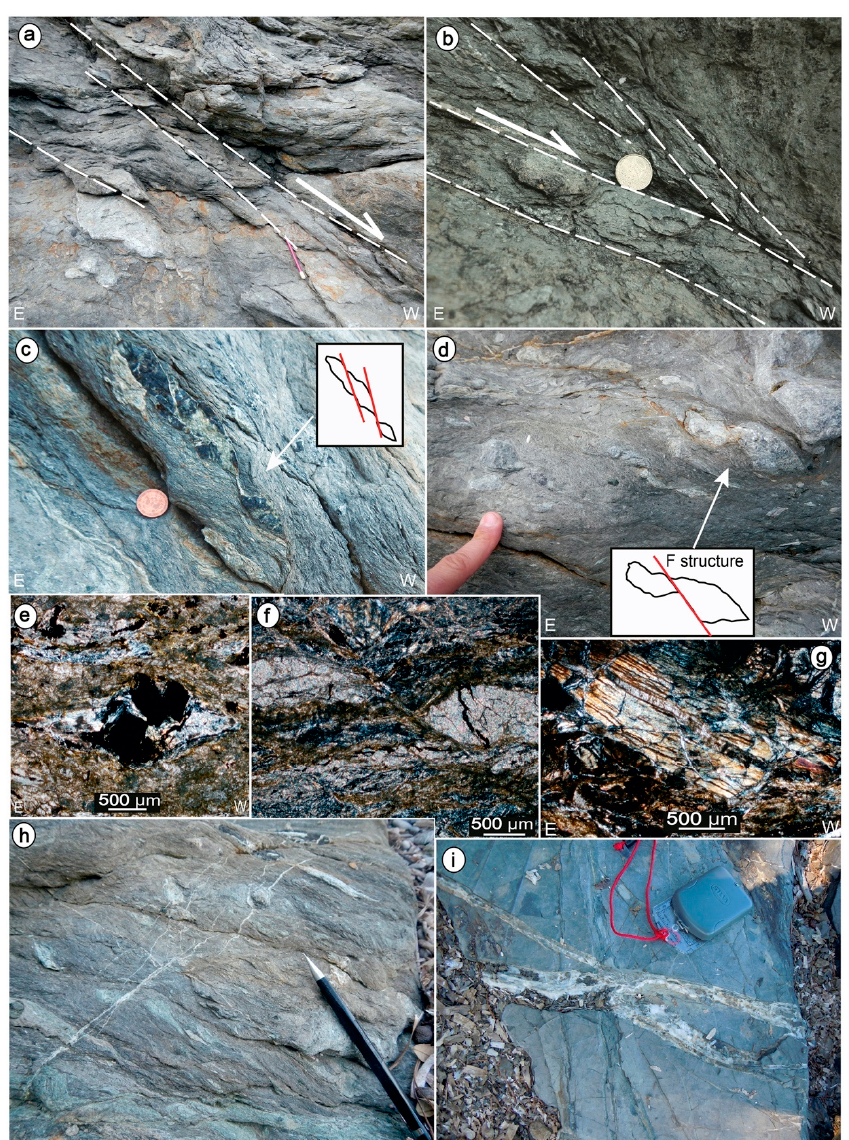
Figure 12. Later brittle structures in ophiolites. ( a ) west-dipping normal fault zone; ( b ) west-dipping faults with calcite mineralization on their slip-planes; ( c , d ) carbonate and ultramafic porphyroclasts dislocated by west-dipping fault (F-structure); ( e ) crossed polars micrograph showing a sliced up magnetite porphyroclast; ( f ) crossed polars micrographs showing a magnesite porhyroclast cross cut by a west-dipping fault; ( g ) crossed polars micrograph showing a fragmented pyroxene cross cut by magnesite veins; ( h ) calcite veins overprinting previous brittle structures cross cutting porhyroclasts; ( i ) calcilutite cross cut by calcite veins with internal small regular elements, testifying a possible contribute of hydraulic pressure during the fracturing process.